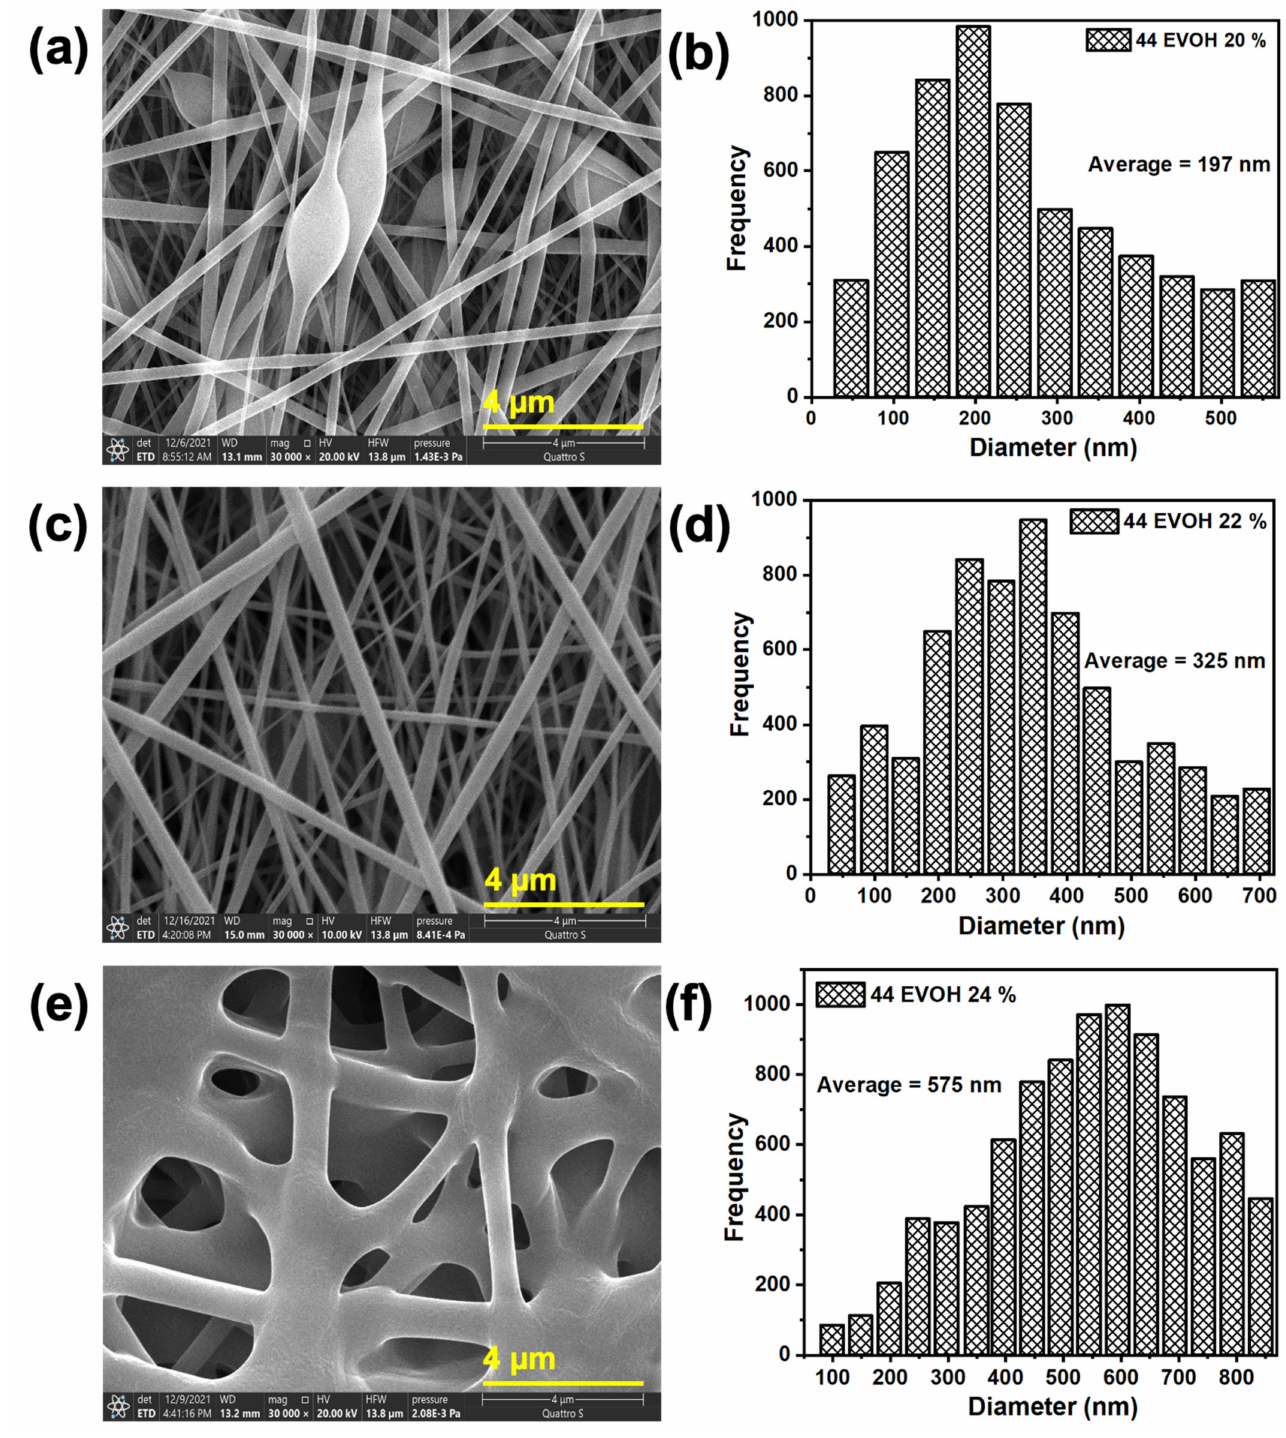
Figure 3. SEM images and fiber diameter of 44EVOH at different polymer